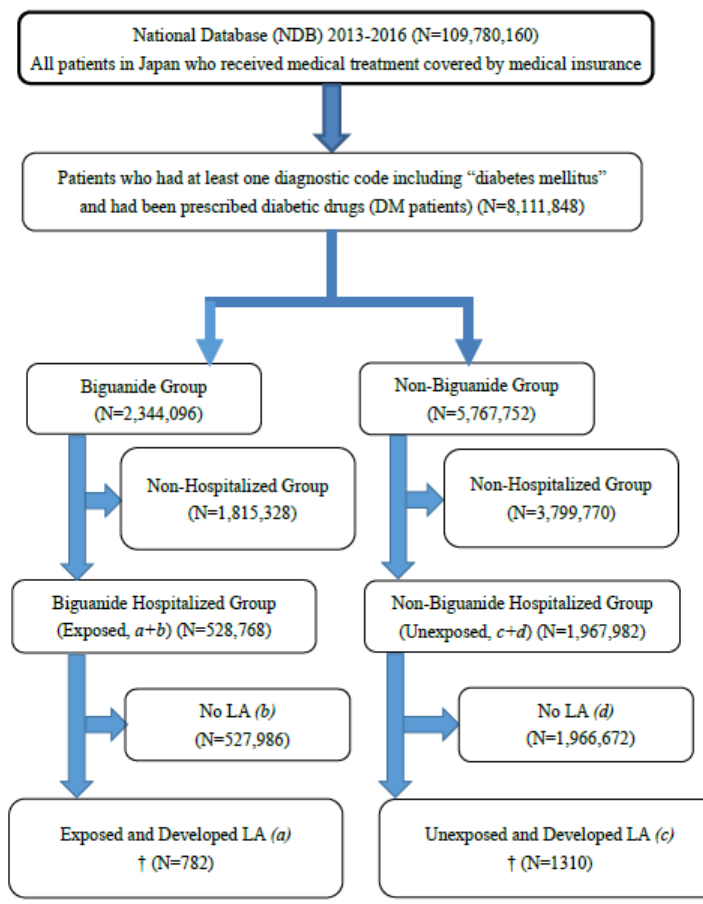
Figure 1. Retrieval Flow Chart for DM and LA Patients. † Acidosis was retrieved using ICD-10 code E87.2, and only LA was extracted using the disease code 20072477.